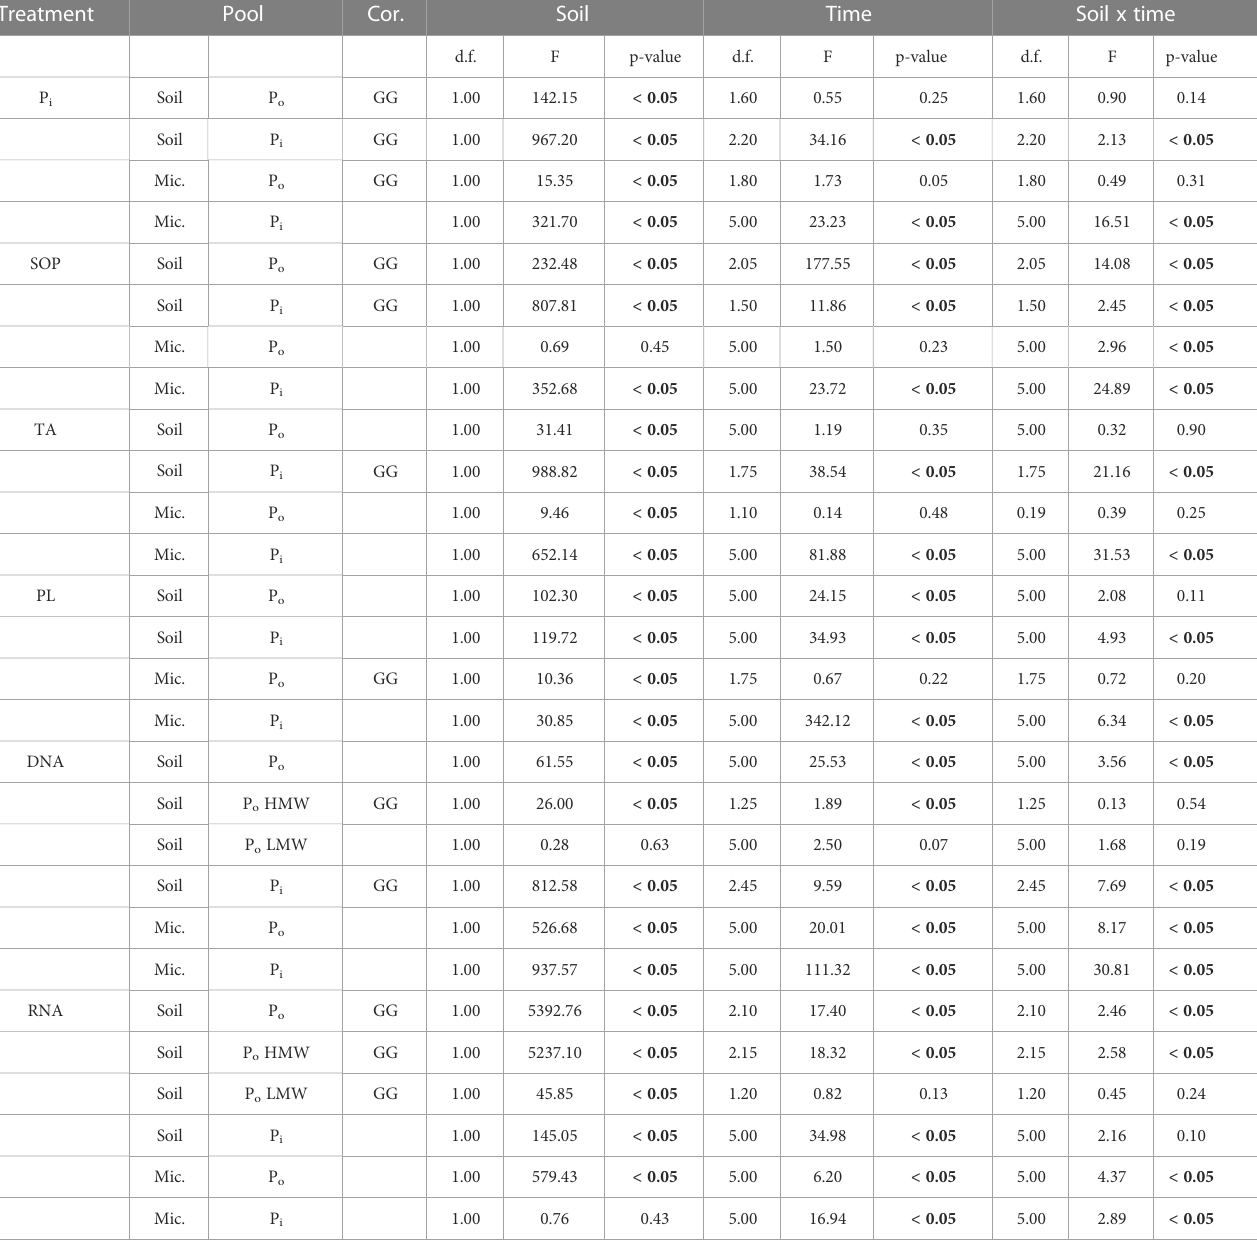
TABLE 2 Differences of 33 P recovery from extractable soil and microbial organic (P o ) and inorganic (P i ) phosphorus pools, across time and between soils. Treatment Pool Cor.